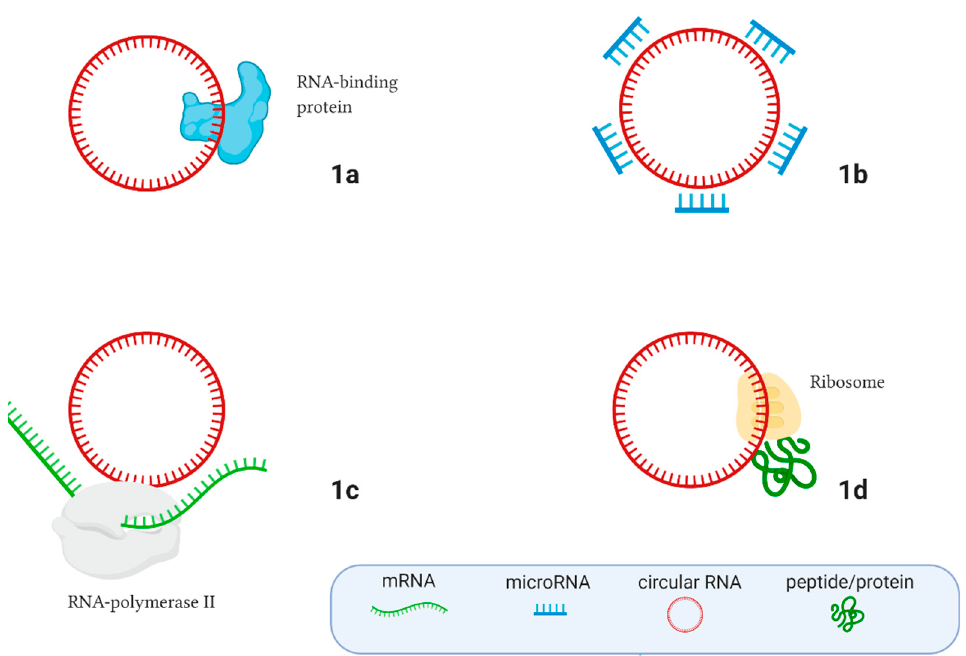
Figure 1. The main regulatory functions of circular RNAs in the cell. ( A ) Interacting with RNA-binding proteins; ( B ) Moderating microRNA expression, acting like microRNA sponges; ( C ) Interacting with RNA polymerase II and regulating gene expression; ( D ) Peptide/protein translation. Created with BioRender.com.